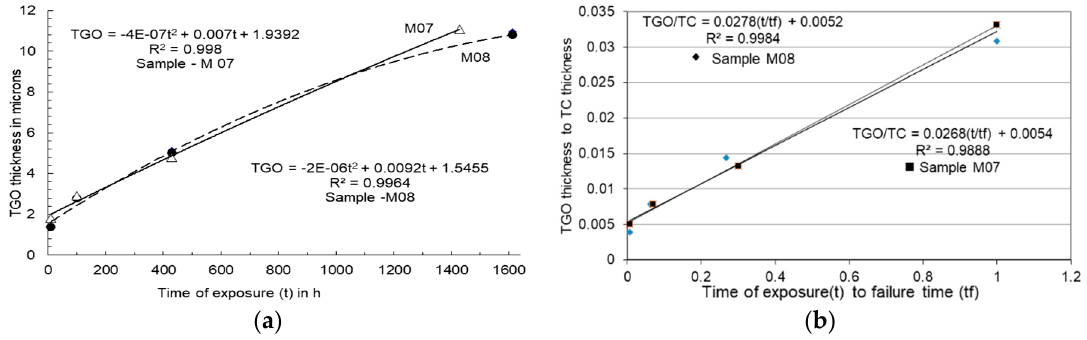
Figure 4. ( a ) Nonlinearity trend for TGO thickness vs. time of exposure fitted with 2-degree polynomials; ( b ) Linearity trend with parameterized data for TGO thickness and thermal exposure for both samples.